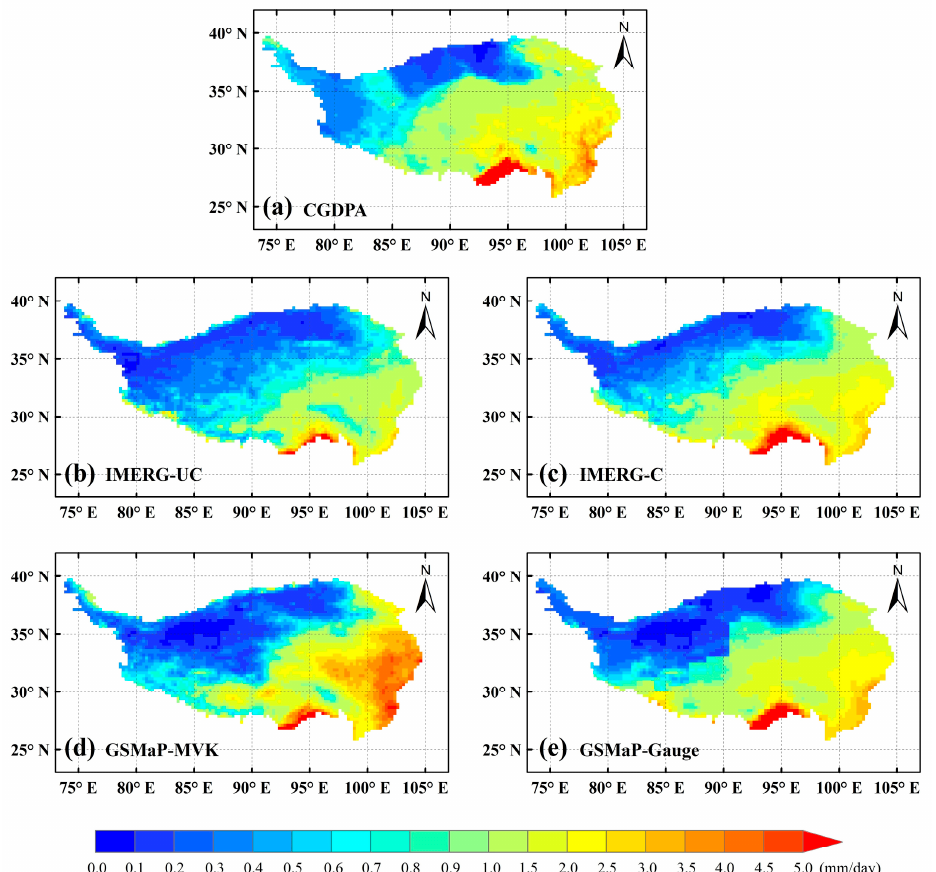
Figure 2. Spatial distributions of mean annual precipitation for ( a ) CGDPA, ( b ) IMERG-UC, ( c ) IMERG-C, ( d ) GSMaP-MVK, and ( e ) GSMaP-Gauge over the TP during the period of April 2014–March 2017.